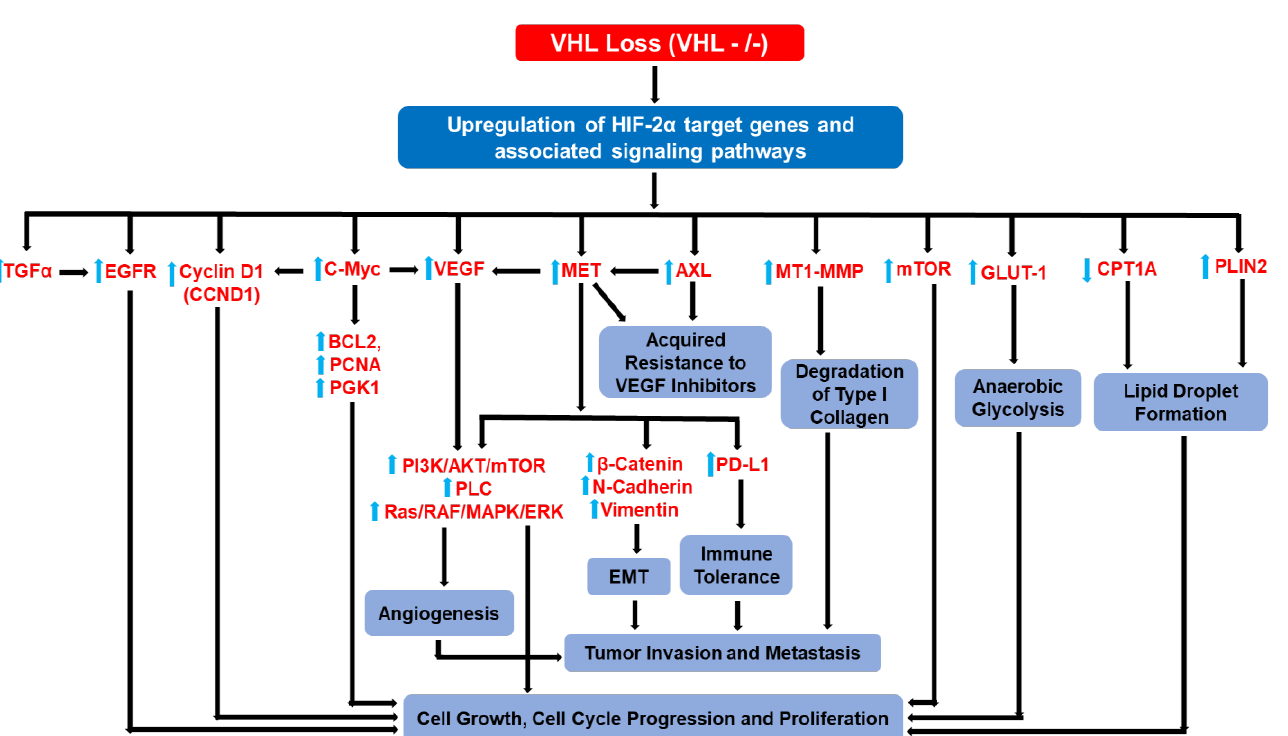
Figure 3. HIF-2 α -induced genetic responses and the associated oncogenic hierarchical events leading to ccRCC progression. HIF-2 α induces the expression of multiple target genes (e.g., EGFR, CCND1, c-Myc, MET, VEGF, mTOR, GLUT1, CPTA1). Such gene reprogramming events promote